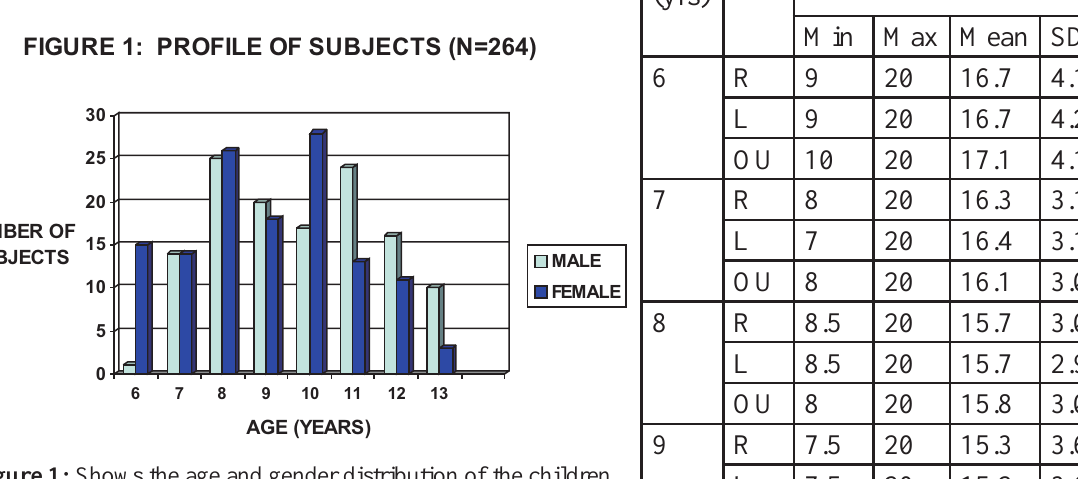
Figure 1: Shows the age and gender distribution of the children included in the study. The females were in the majority for the six, eight and ten year olds and the males were the majority for the other age groups.